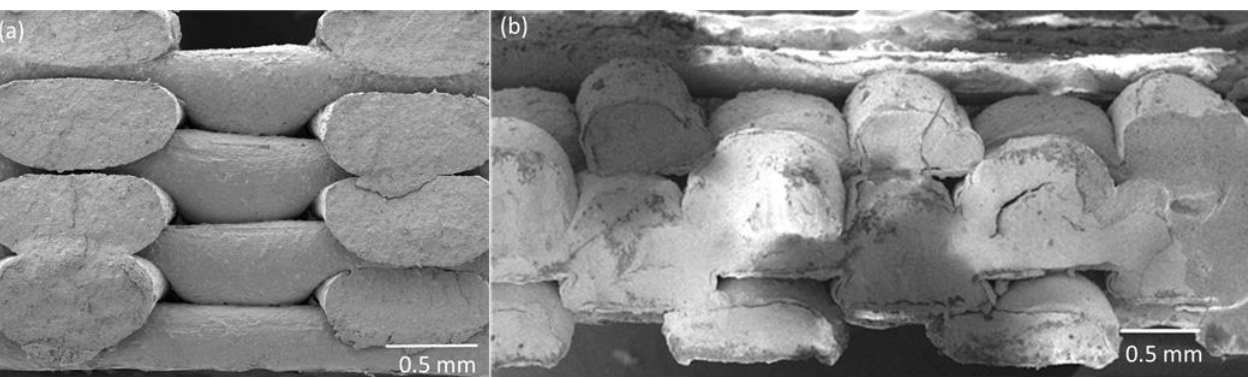
Figure 5. SEM figure of 3D printed ( a ) scaffold structure, and ( b ) 3D printed offset structure.